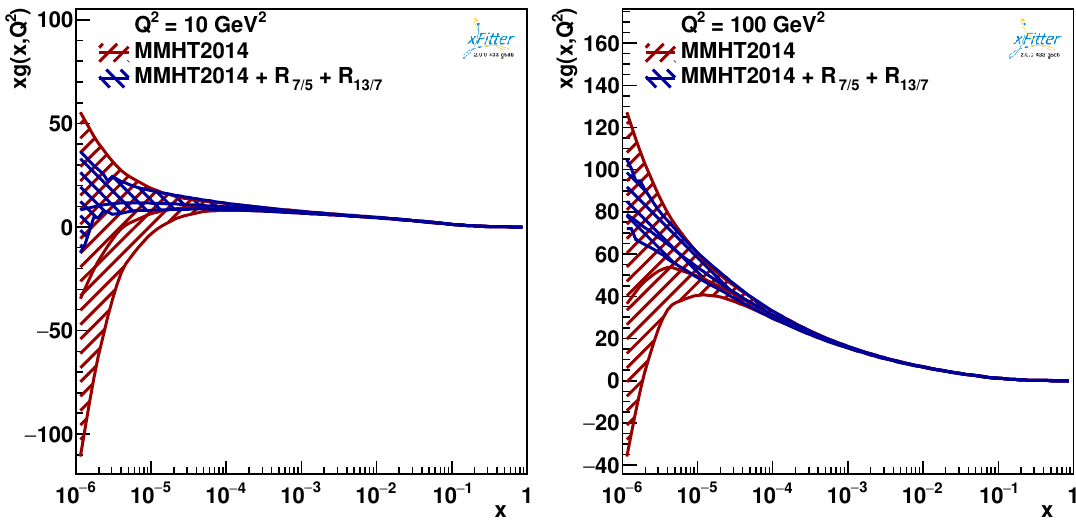
Figure 20 . The gluon distribution of the original and profiled MMHT2014 NNLO PDF set at Q 2 = 10 GeV 2 (left) and Q 2 = 100 GeV 2